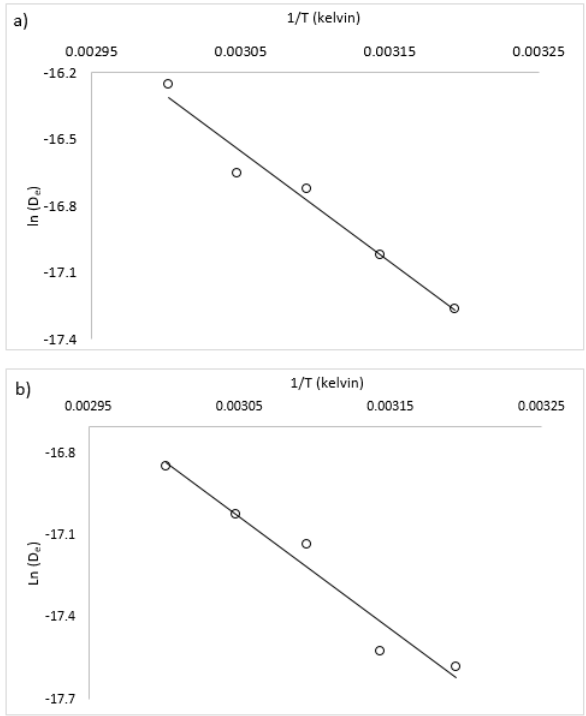
Figure 6. Graphical solution method for calculation of activation energy and diffusion pre-exponent, ( a ) U. ohnoi and ( b ) O. intermedium . Table 5. Activation energy and diffusion pre-exponent for radiative drying. D0O